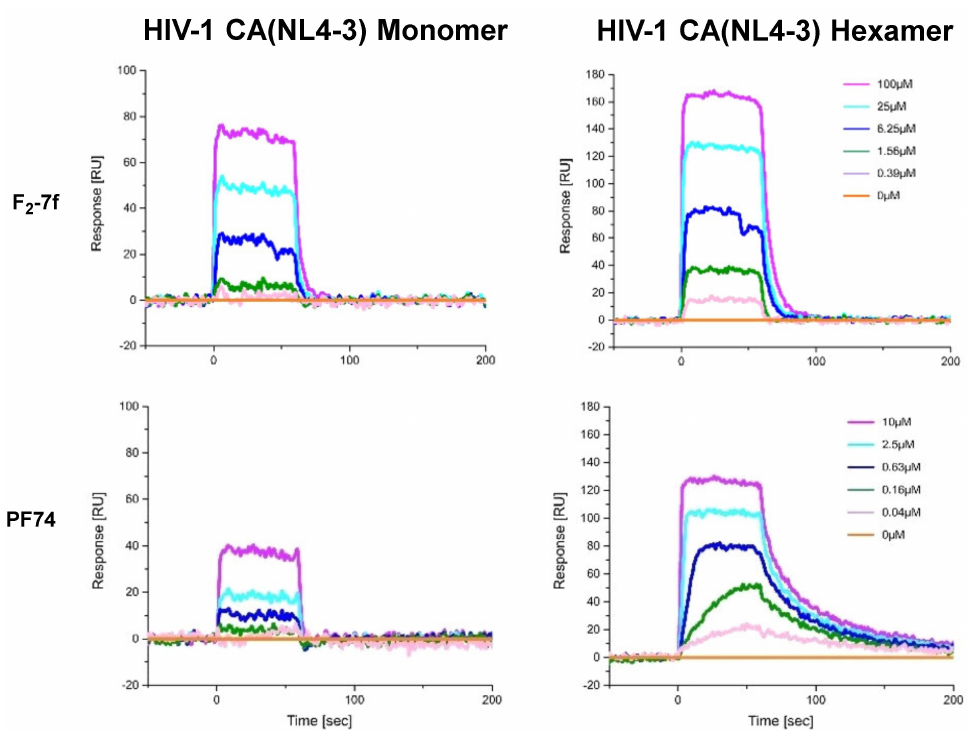
Figure 2. SPR sensorgram depicting the interaction of F 2 -7f and PF74 with two HIV-1 CA variants (monomer and disulfide-stabilized hexamer).